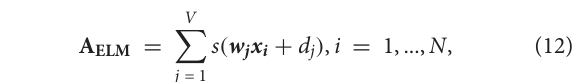
TABLE 5 | The hyper-parameter settings of the proposed